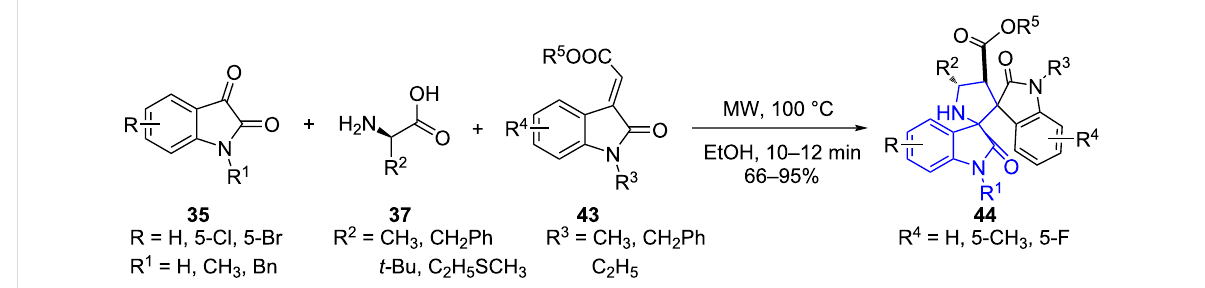
Scheme 15: Synthesis of pyrrolidinyl spirooxindoles.